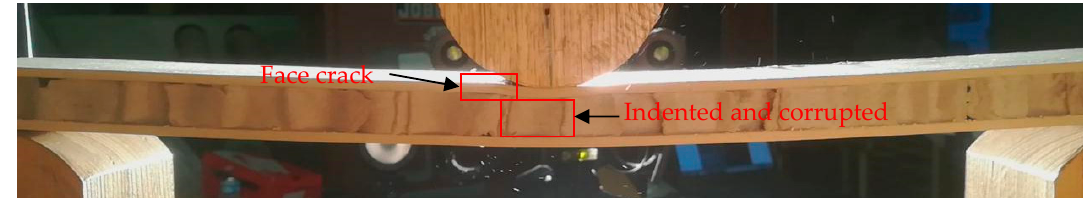
Figure 12. Photograph of indentation combined with face yield under three-point bending.